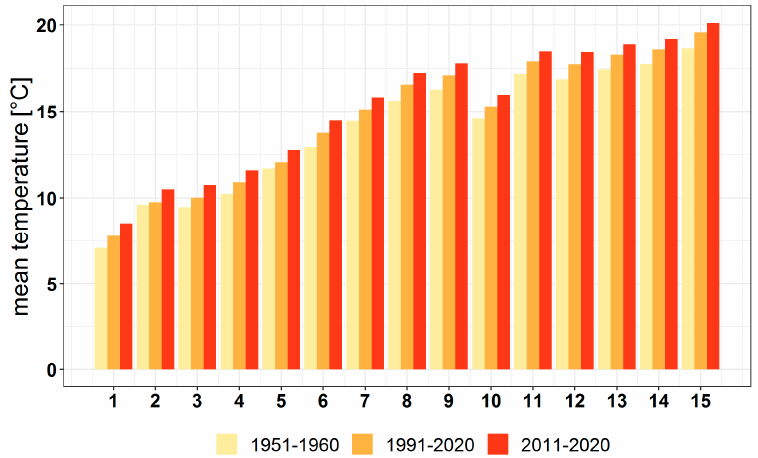
Figure 12. The variation of MT VS over the analyzed period for the main forest types.